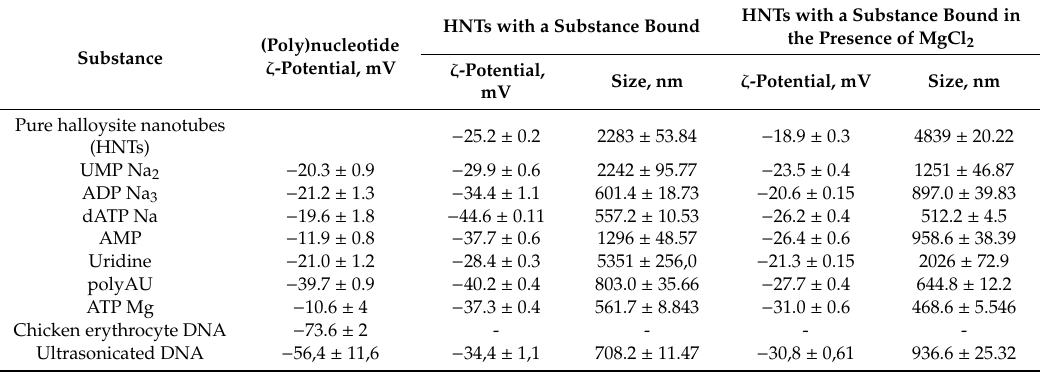
Table 1. ζ -potentials and hydrodynamic diameters of pure and (poly)nucleotide species treated halloysite in the presence or absence of MgCl 2 (10 mM). In the case of ultrasonicated DNA binding was performed at MgCl 2 (100 mM).